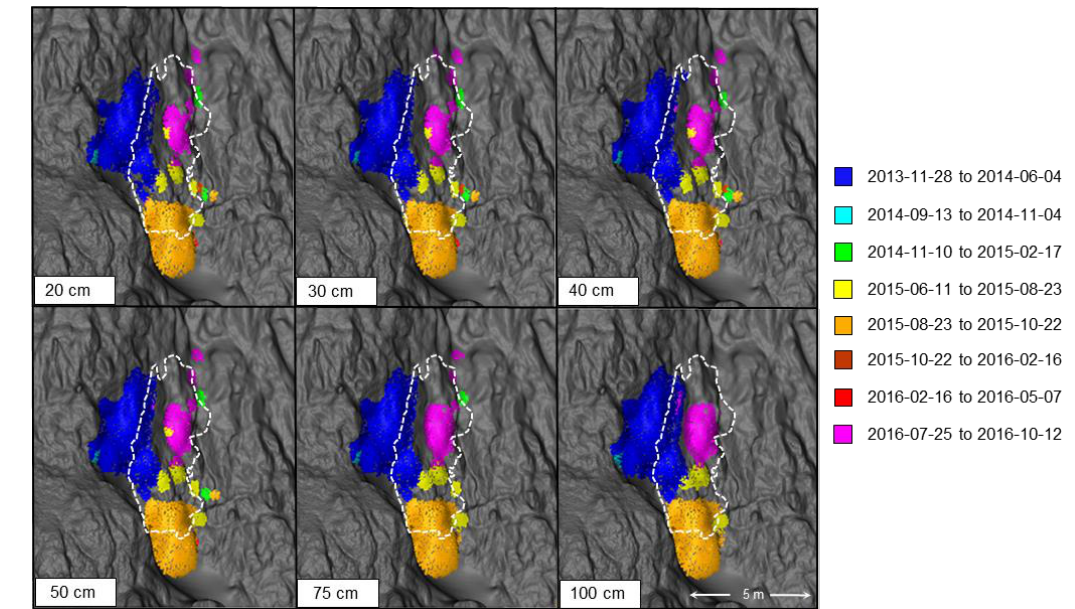
Figure 17. Precursor rockfall activity seen prior to the 16.7 m 3 event, which can be seen outlined by the white dashed line. All six inventories are shown, and events are colored according to their time range of occurrence. Events within the perimeter of the eventual failure correspond to fragments which failed o ff the face of the eventual 16.7 m 3